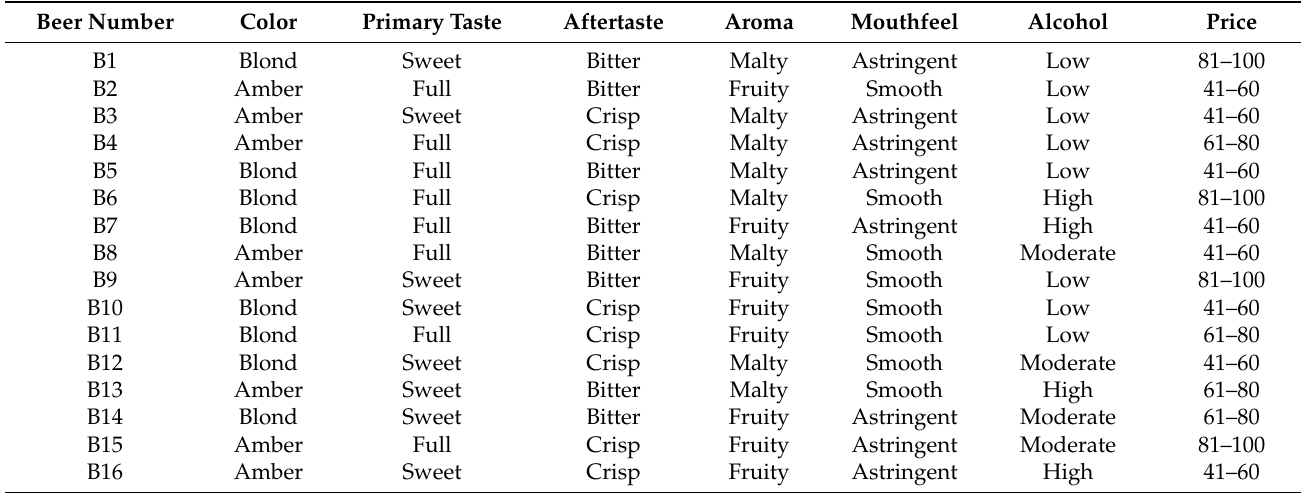
Table 2. Stimuli generated with the orthogonal design.